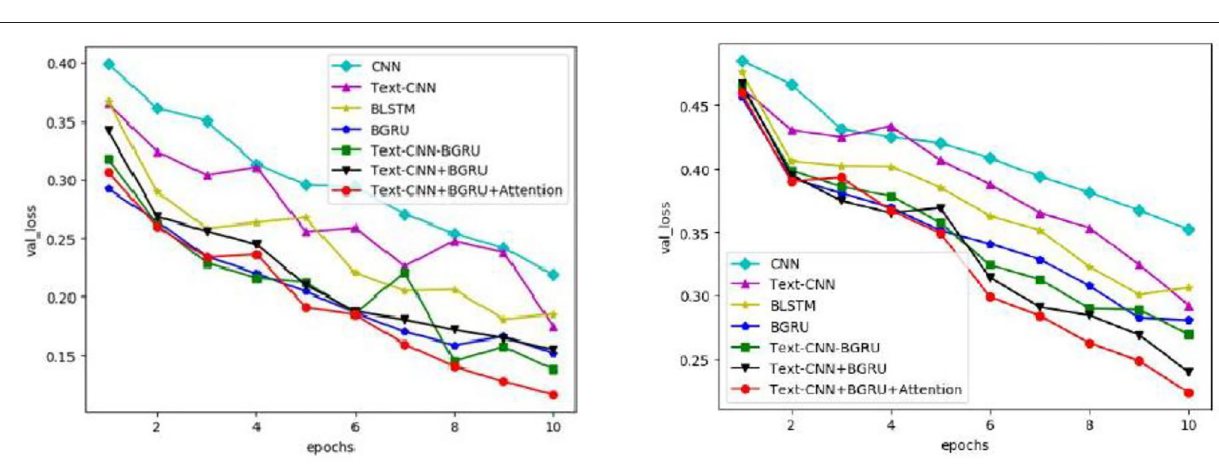
FIGURE 6 | Variation of loss of the verification set for different